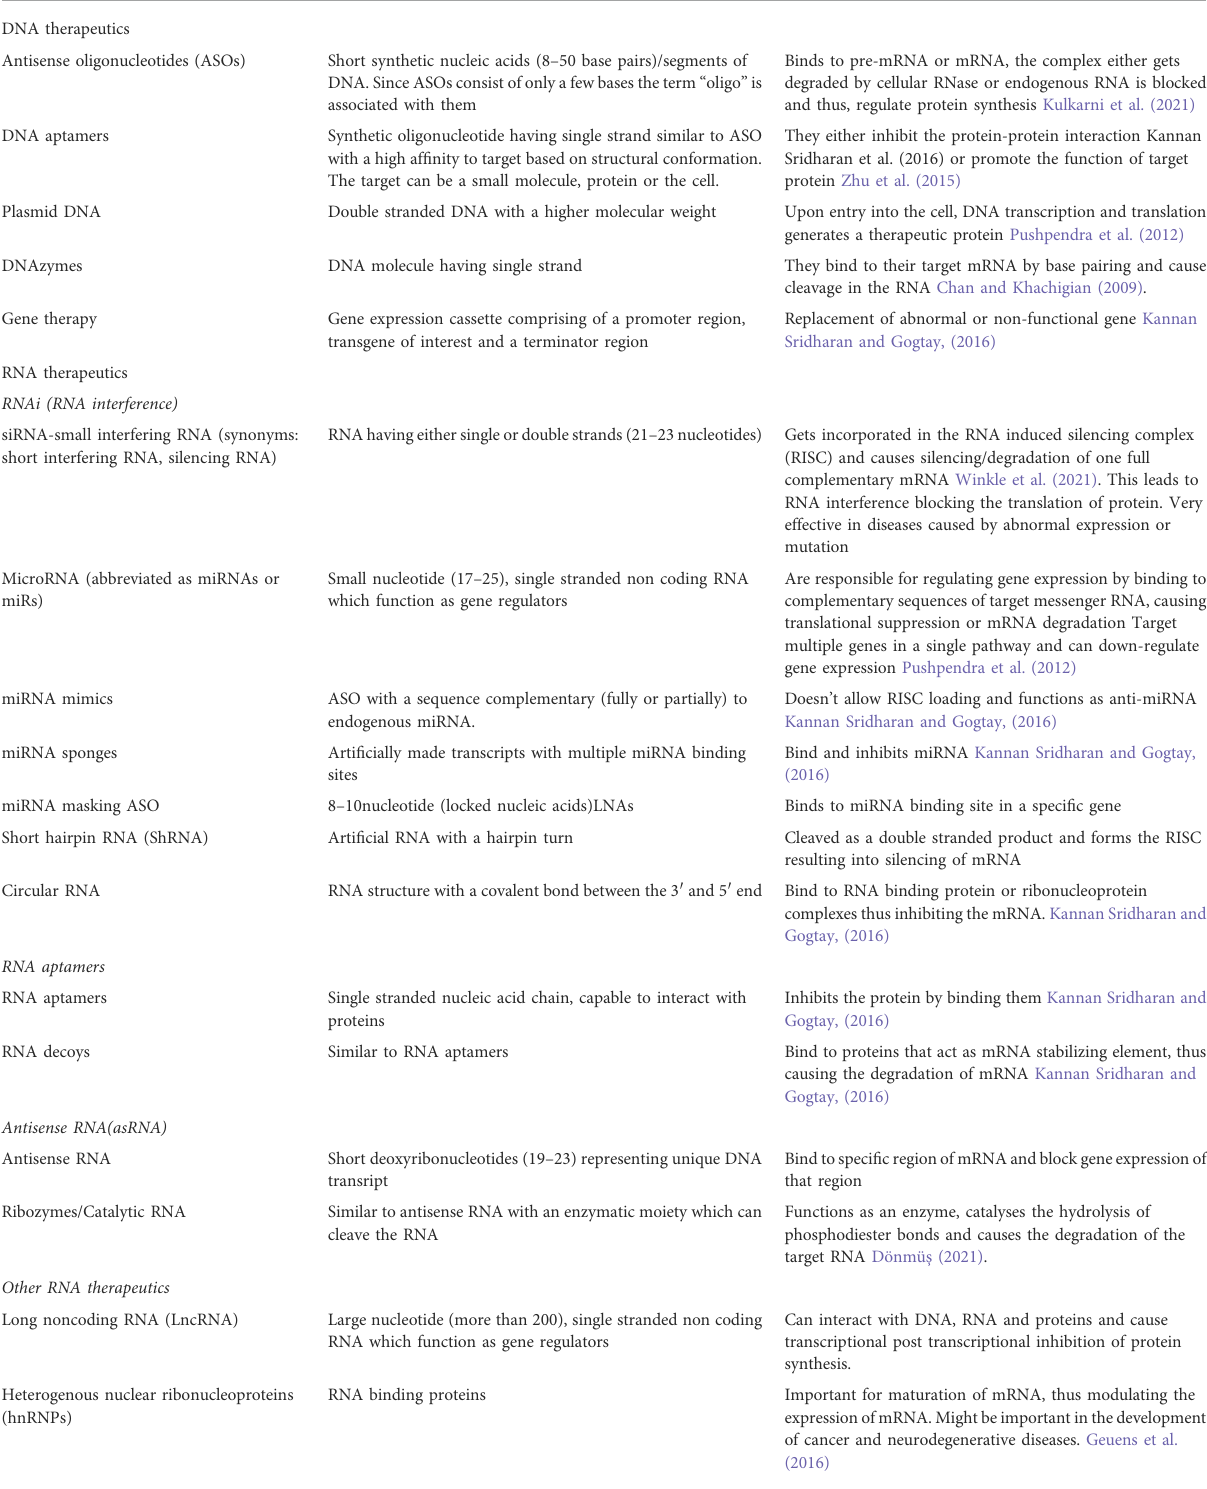
TABLE 1 Structure and mechanism of